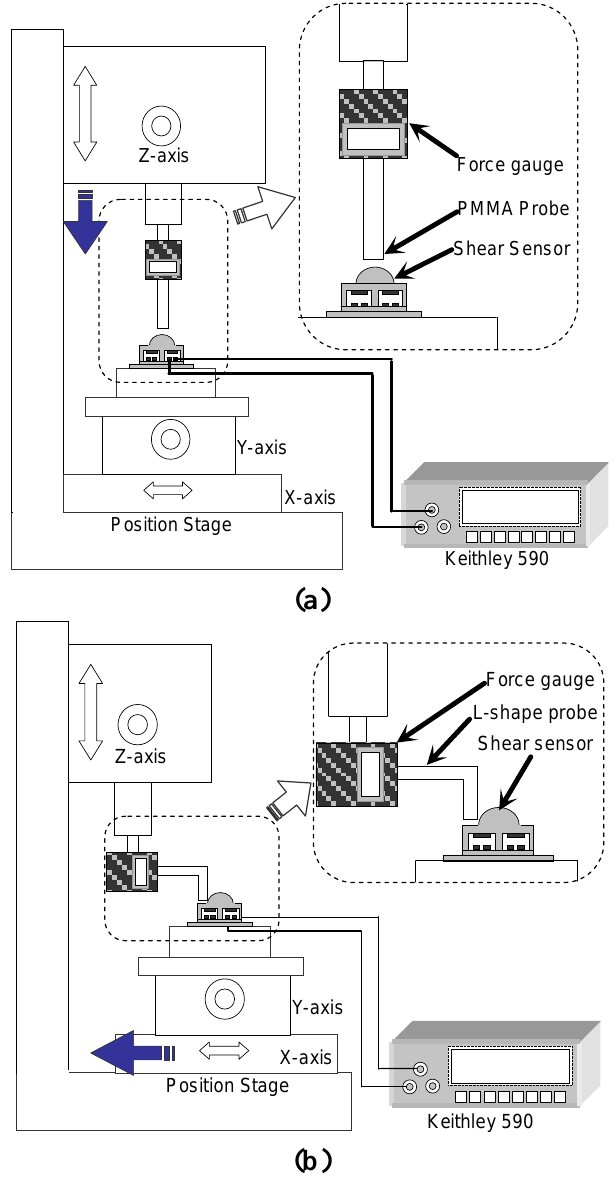
Figure 7. Experimental setup for measuring the capacitance of shear sensor elements with (a) applied normal force and (b) applied shear